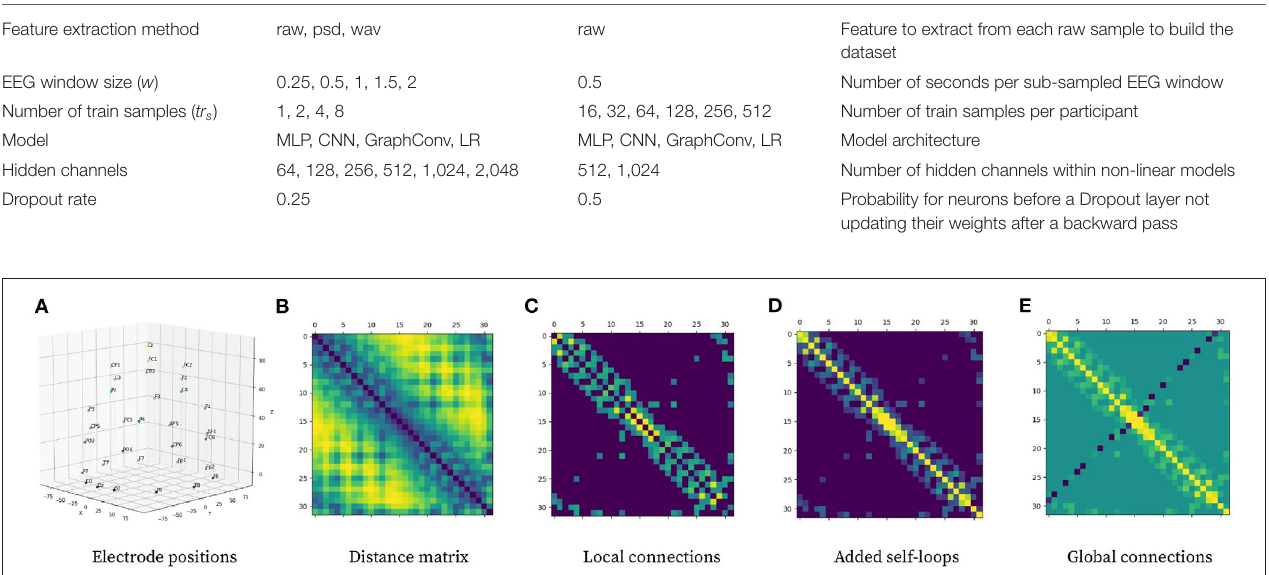
FIGURE 4 | Pipeline for computing graph adjacency matrix from electrode 3-D position. (A) Electrode positional information in 3-D space. (B) Distance matrix representing Euclidean distance between electrodes. (C) Local connections using (2) with δ = 5. (D) Local connection matrix with added self-loops. (E) Global connections to local connection matrix with self-loops using